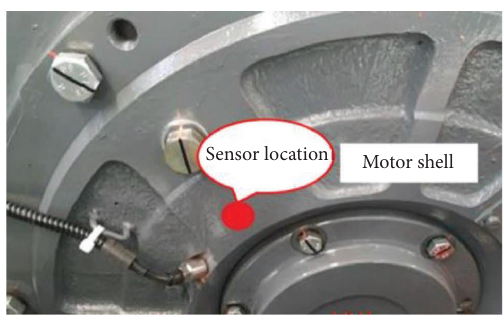
Figure 6: Bearing temperature sensor location.